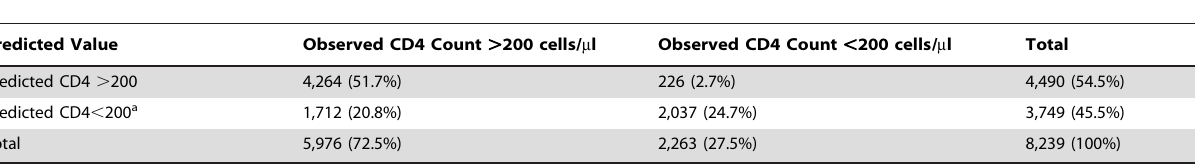
Table 4. Observed and predicted values resulting from application of PCB to Cohort 1.